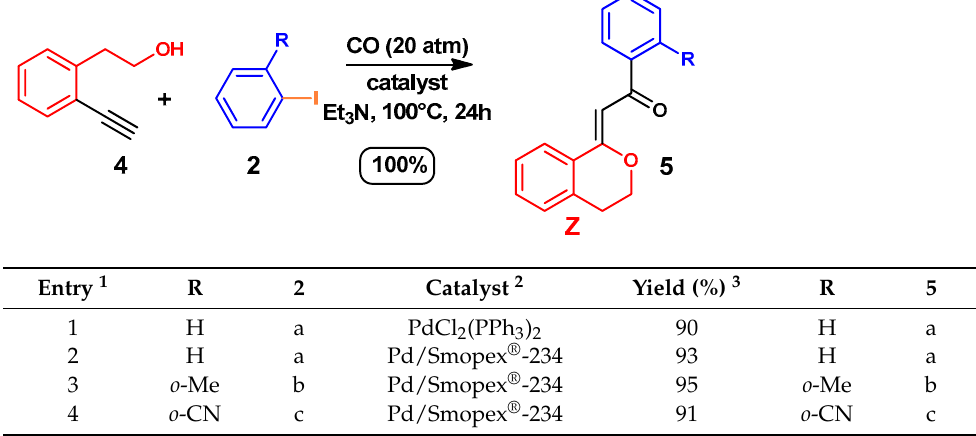
Table 2. Palladium - promoted synthesis of isochromans via cyclocarbonylative Sonogashira Table 2. Palladium-promoted synthesis of isochromans via cyclocarbonylative Sonogashira reactions.